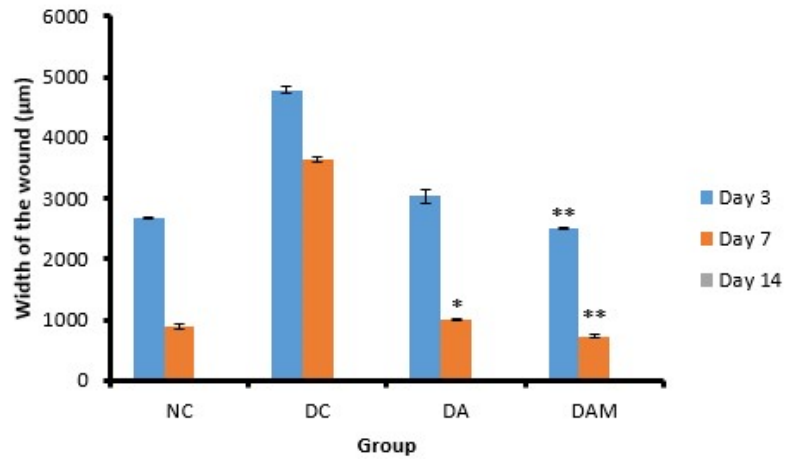
Figure 5. Wound width at the three variation times. Notation on the graph shows the result of the statistical test ( α < 0.05). * and ** notation shows insignificant differences with NC but significant differences with DC. * = 0.01 ≤ α < 0.05; ** = α ≤ 0.01. NC: normal group; DA: alginate treatment group; DAM: alginate–mangosteen rind extract treatment group; and DC: diabetic group.